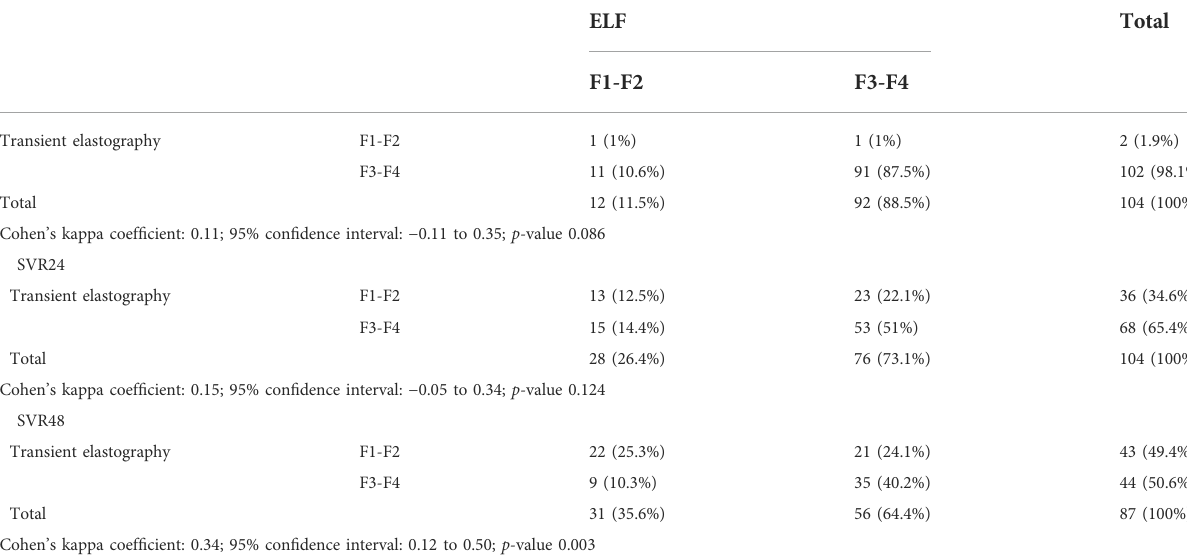
TABLE 2 Concordance between ELF and transient elastography at baseline, SVR24, and SVR48. Baseline